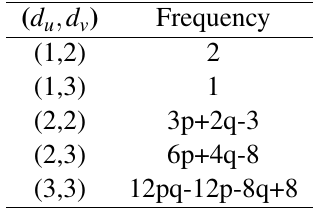
Table 2 Edge partition of SiC 3 − III [ p , q